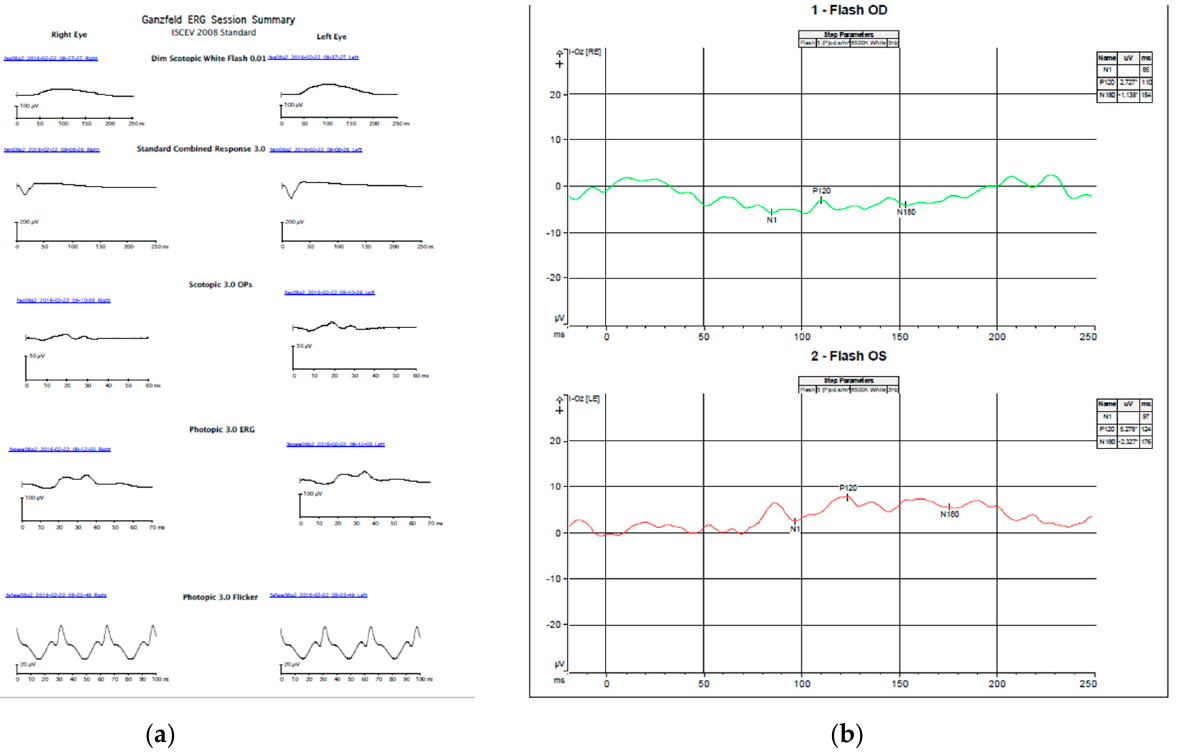
Figure 2. Electrophysiology of the child ( a ) sedated full-field ERG using Burien Allen electrodes and the Vera system. Both dark and light-adapted waveforms and amplitudes were normal compared with our standards for sedated ERG ( b ) Awake flash VEP performed using a Dyagnosis system. Very low, almost non-recordable amplitudes bilaterally, right eye worse than left. Pick amplitudes for the P120 waves are 2.27 mV right eye and 5.27 mV left eye. Normal amplitudes are over 6 mV [24].